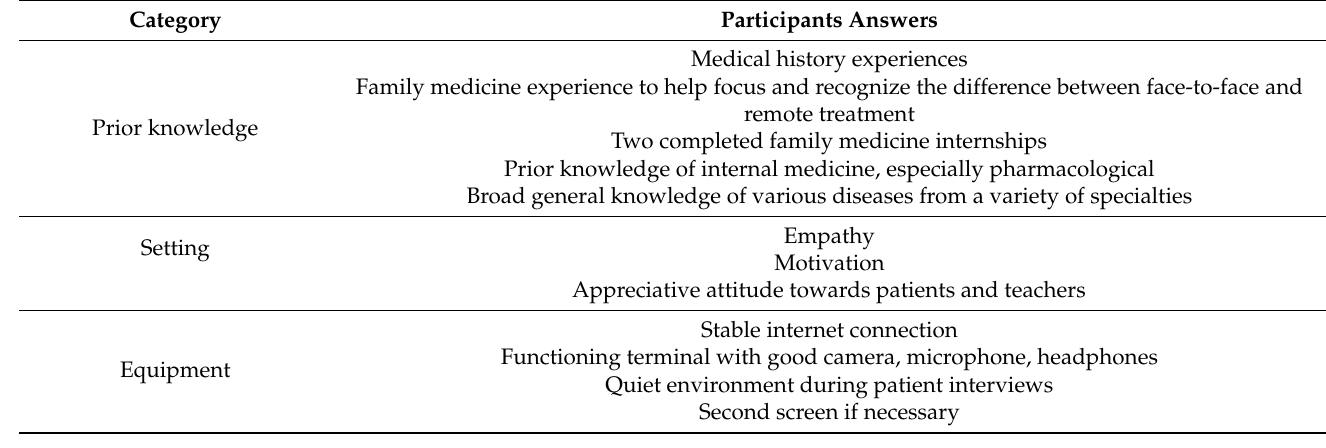
Table 2. Analysis and categorization of free text answers to the following question: “What should future participants bring with them?”.